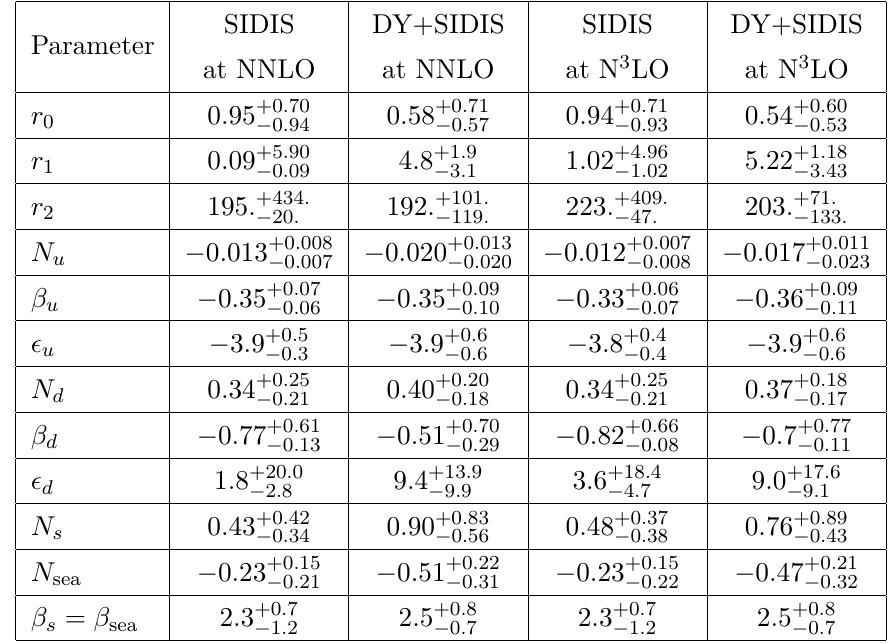
Table 4. Values of parameters obtained in various fits. The visual representation of the table is given in figure